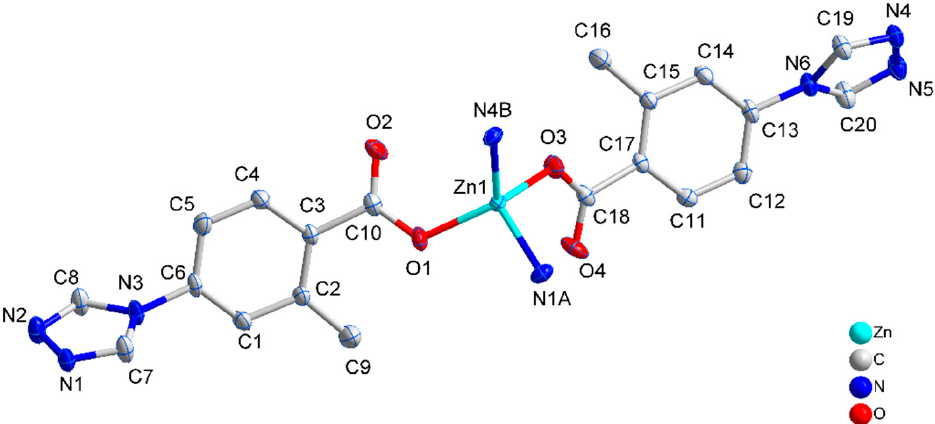
Figure 1. The coordination environment of Zn(II) ion in 1 , with the ellipsoids drawn at the 30% probability level. All of the hydrogen atoms are omitted for clarity. Symmetry code: A 2.5 − x, 0.5 + y, 1.5 − z, B 0.5 − x, − 0.5 + y, 1.5 − z.